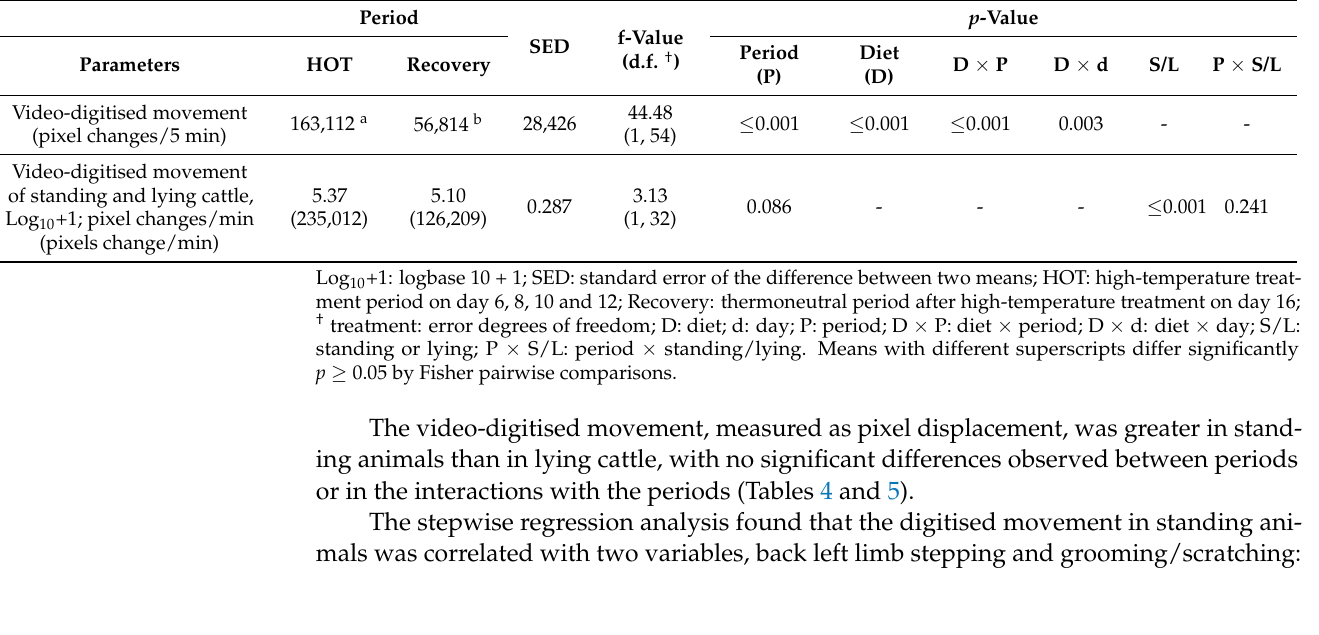
Table 5. Video-digitised movement of cattle ( n = 13) receiving a finisher or substituted diet and exposed to high temperatures (HOT) or a thermoneutral recovery